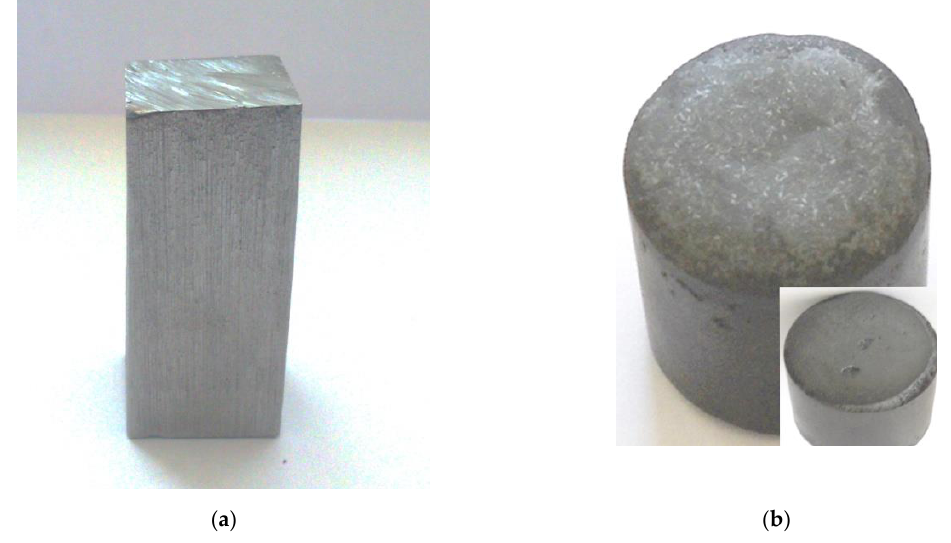
Figure 5. ( a ) Steel sample before measurement; ( b ) steel sample after measurement.